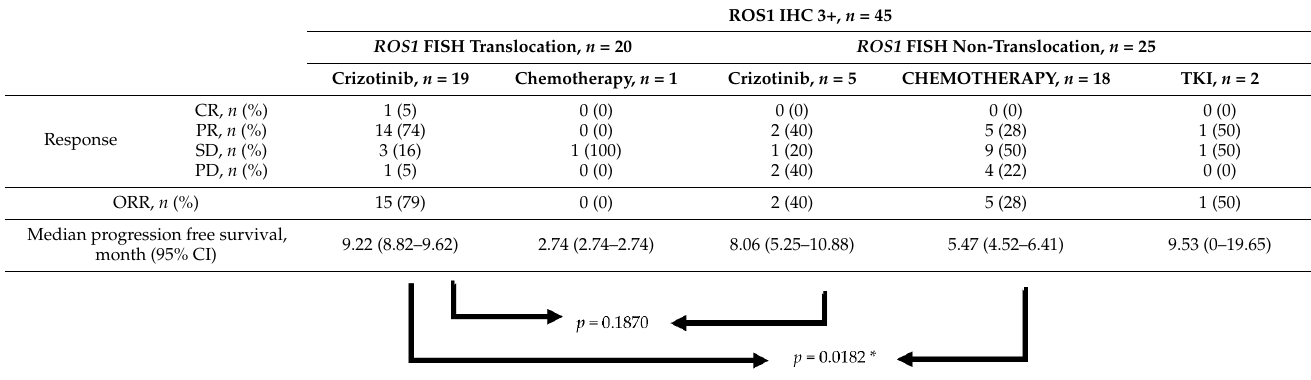
Table 5. Objective response rate of different treatment in ROS1 IHC 3+ cases.